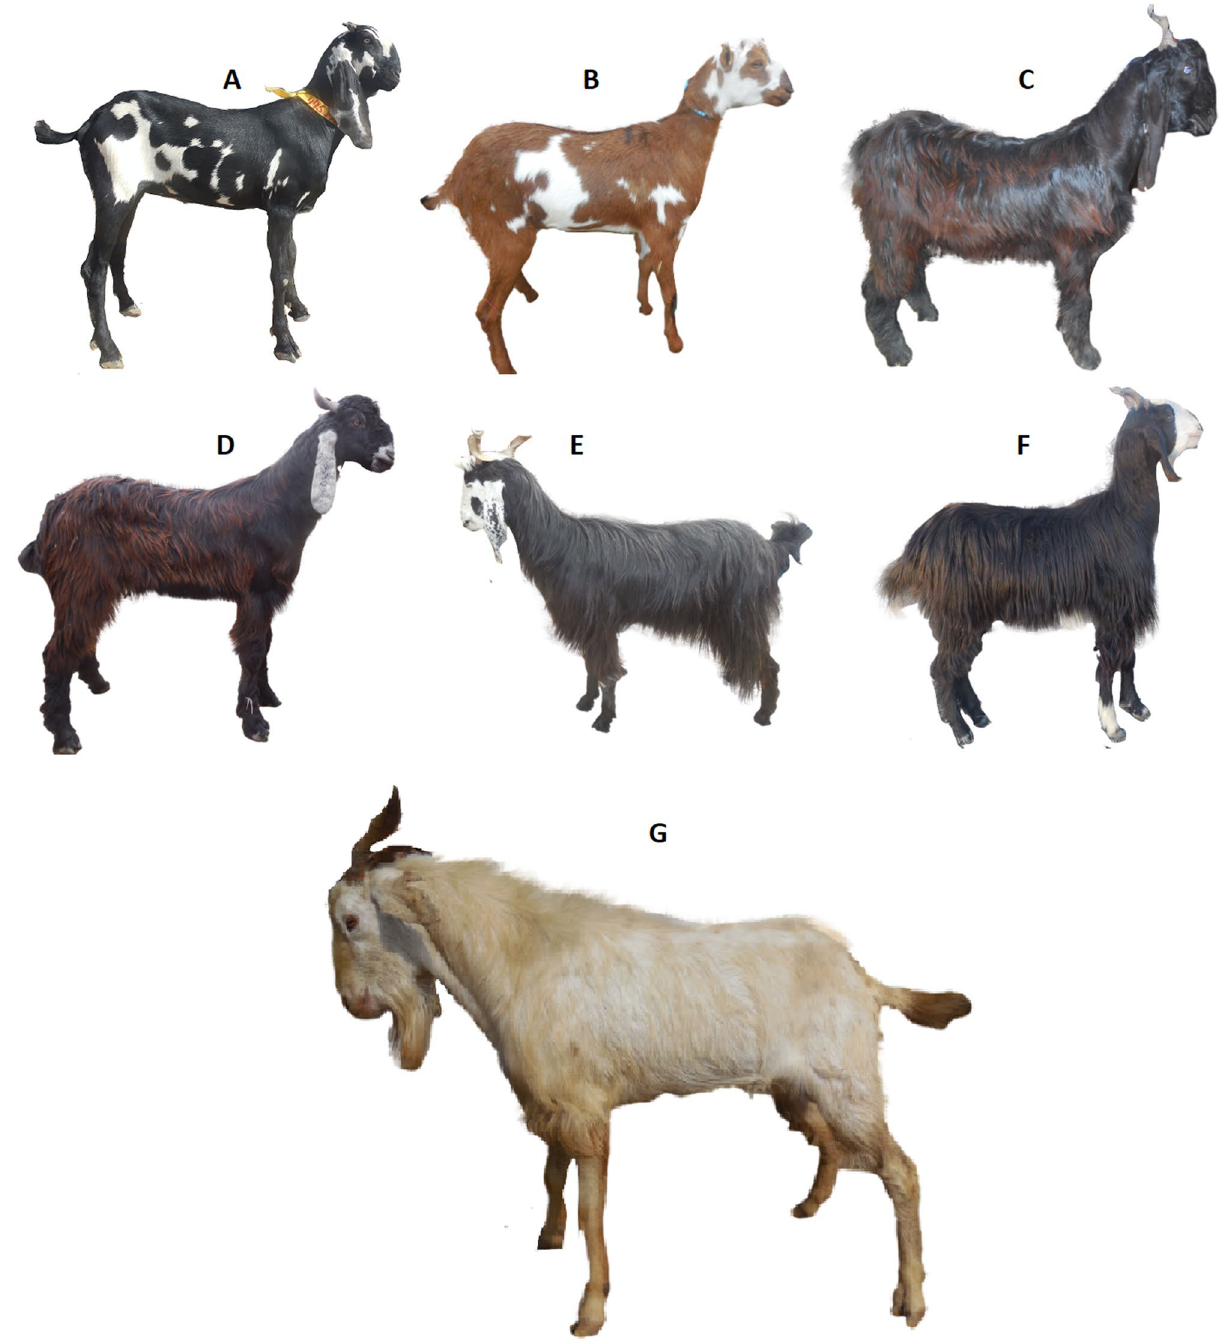
Figure 3. Documented goat breeds of Punjab Pakistan A = Beetal, B = Barbari, C = Daira Deen Panah, D = Nachi, E = Pahari, F = Local Pothwari and G =